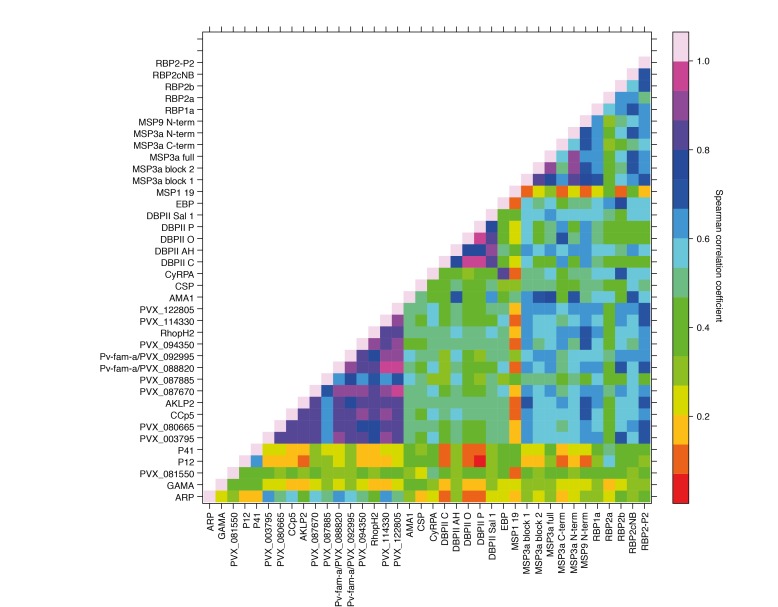
Correlations between IgG to 38 P. vivax proteins in Papua New Guinean children aged 1–3 years.Correlation coefficients between antibody levels to every pair of antigens were calculated using Spearman’s rank correlation tests.